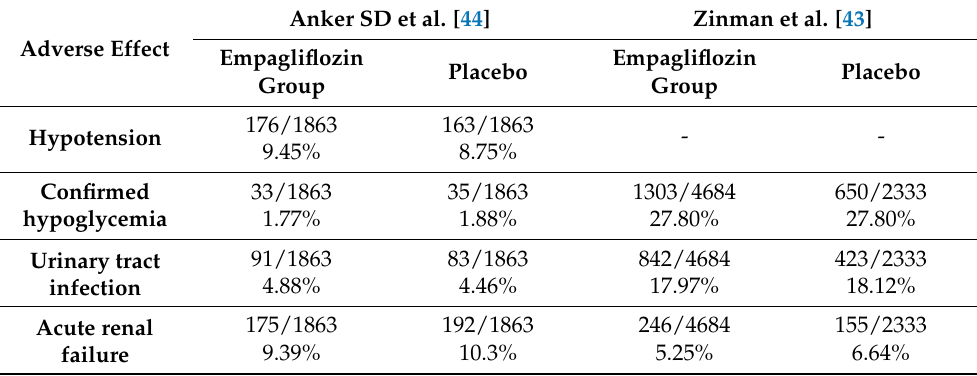
Table 2. Prevalence of major side effects of empagliflozin in the study and placebo